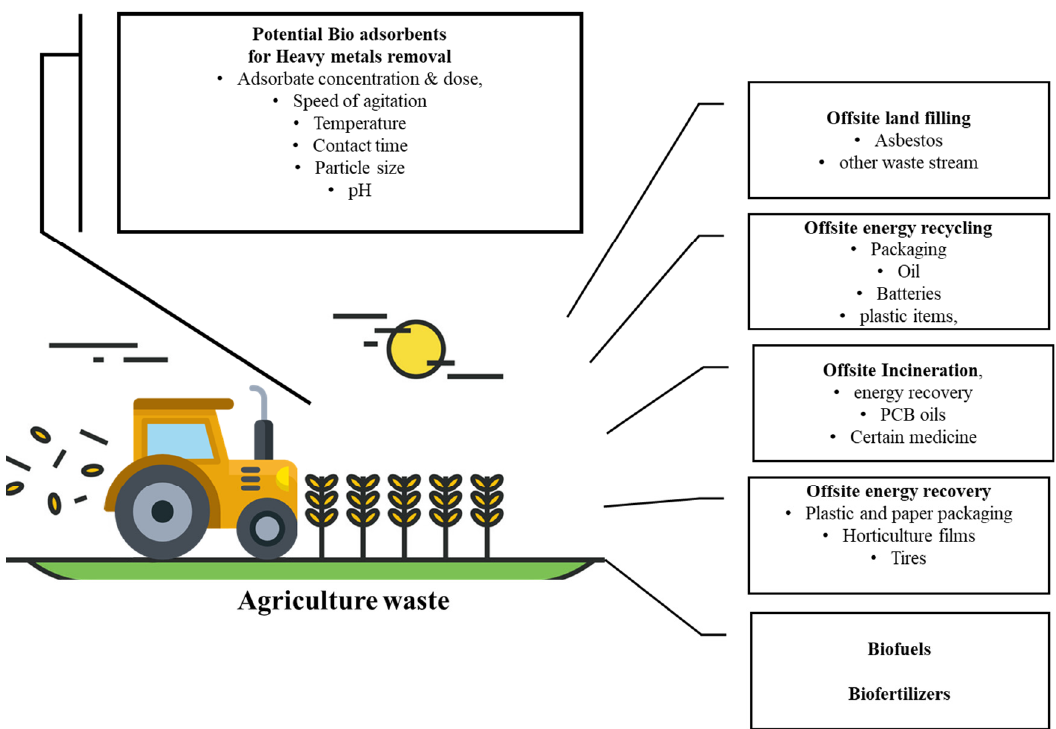
Figure 1. Agricultural waste product usage in different processes.